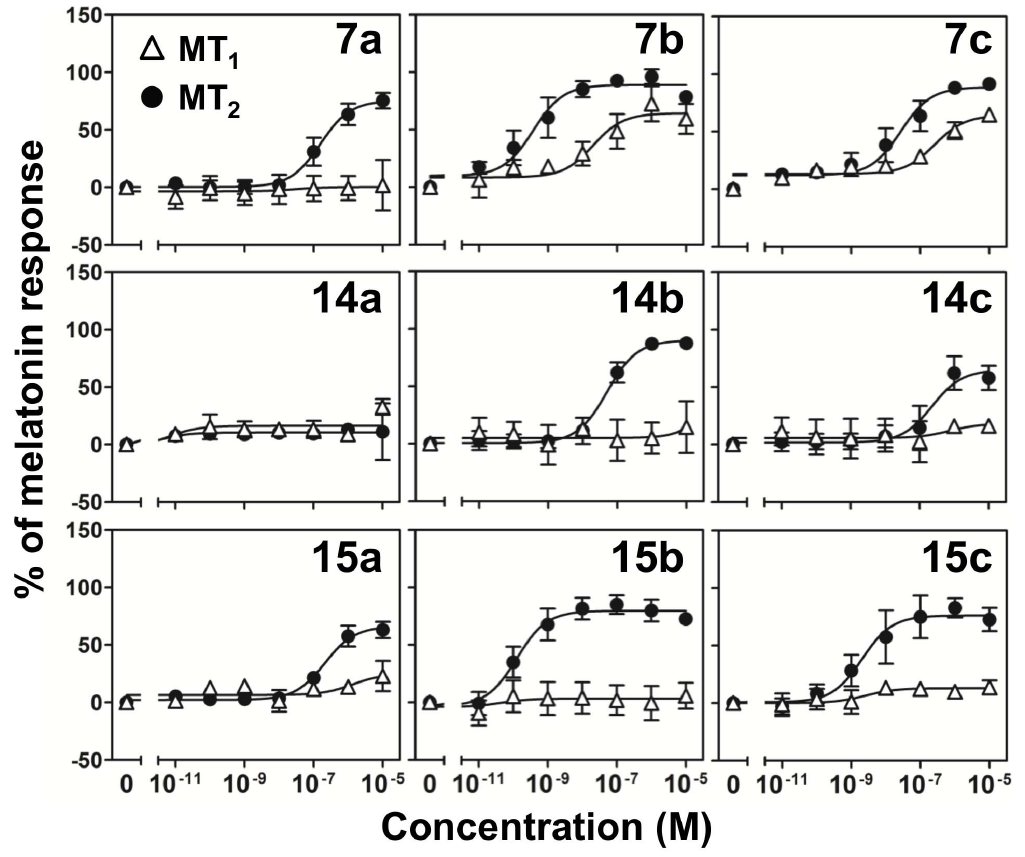
Figure 4. Stimulation of intracellular Ca 2 + mobilization in CHO cells expressing MT 1 or MT 2 by isoquinolinone derivatives. CHO cells expressing MT 1 or MT 2 were subjected to the treatment of increasing doses of selected tested compounds. Data were mean of peak fluorescence signals ¡ SEM of at least 3 different trials performed in triplicates, and normalized to the maximal response elicited by melatonin (as 100%) and the minimal response of vehicle- treated cells (as 0%). Estimation of maximal responses and EC 50 were tabulated in Table